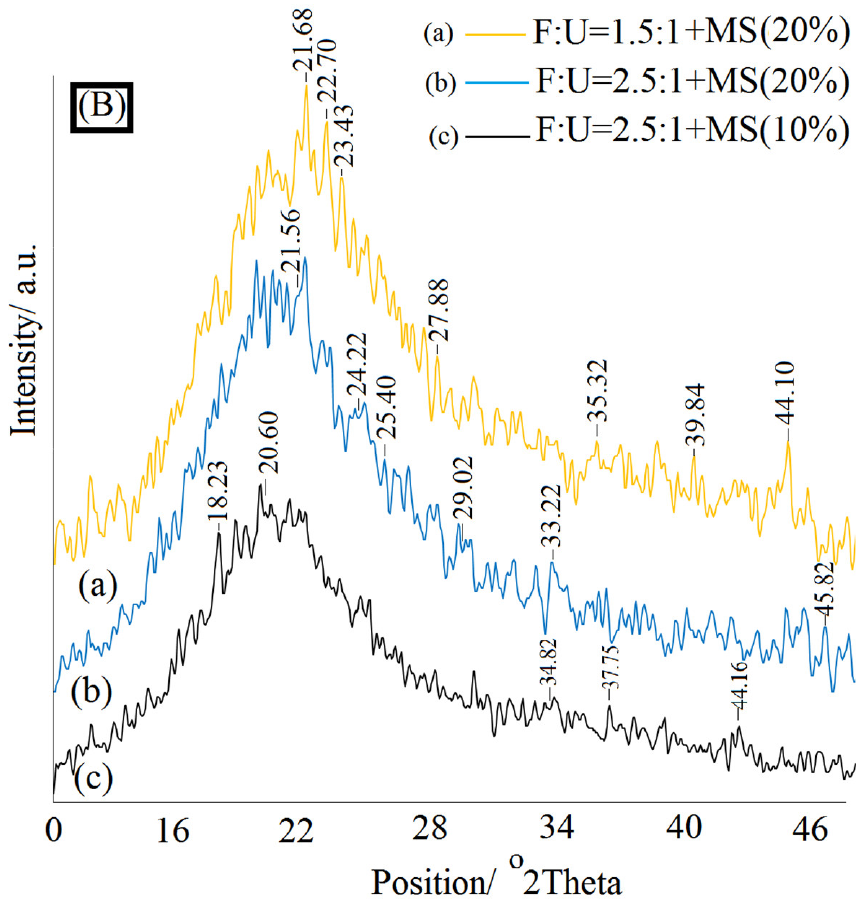
Figure 3. XRD diffractograms of ( A ) neat starch and modified starch by 10% and 20% NaOCl; ( B ) modified starch/urea/formaldehyde adhesives synthesized by different F:U molar ratios.